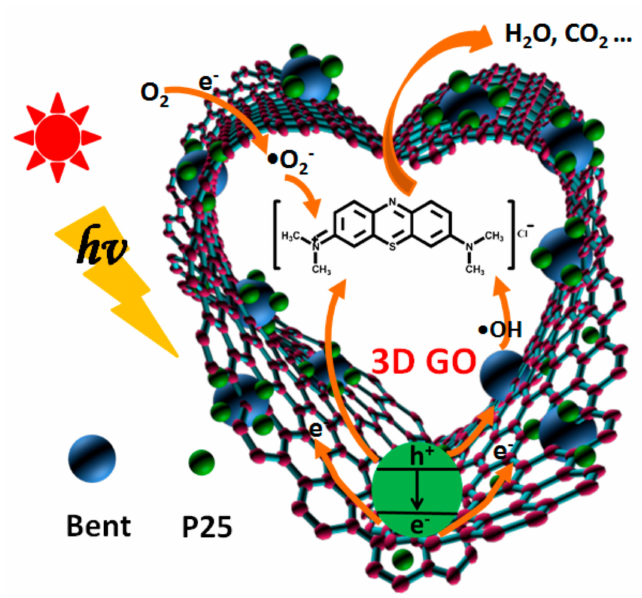
Figure 12. The photocatalytic degradation mechanism of MB based on GO / TiO 2 / Bent